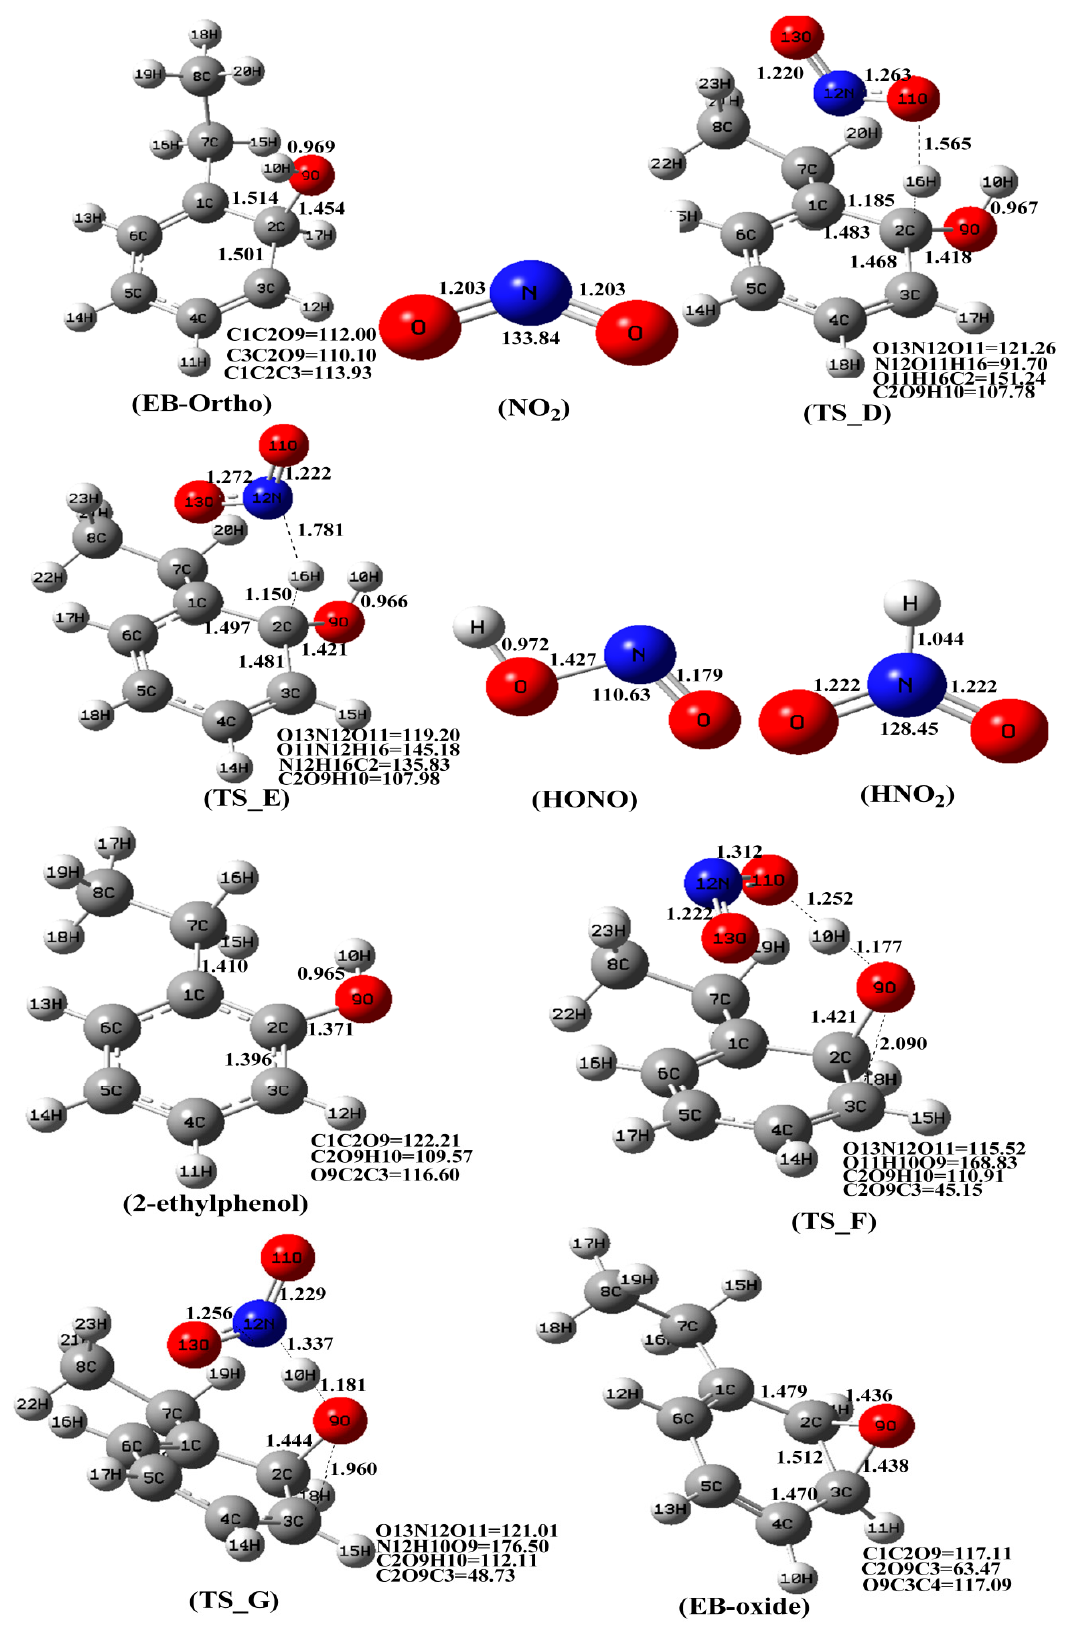
Figure 8. Optimized geometries of various species of Path D to Path G, as shown in Figure 2, the at BHandHLYP/6-311++G (d,p) level (Bond length: Å, Bond angle: °).